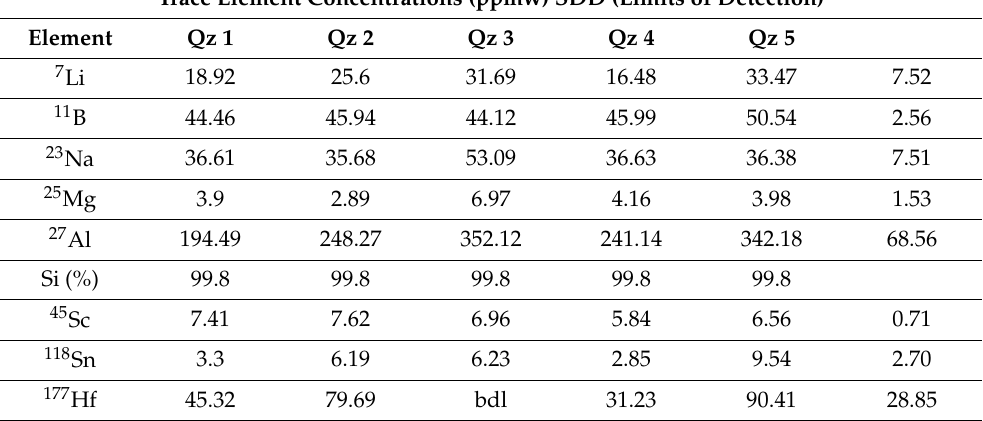
Table 2. Trace element composition of the quartz investigated in this work, obtained through LA-ICP- MS analysis (three spots per sample; the values in table are the averages). The elements that resulted below the detection limits (bdl) are not reported; detection limits are reported in [40]. Trace Element Concentrations (ppmw) SDD (Limits of